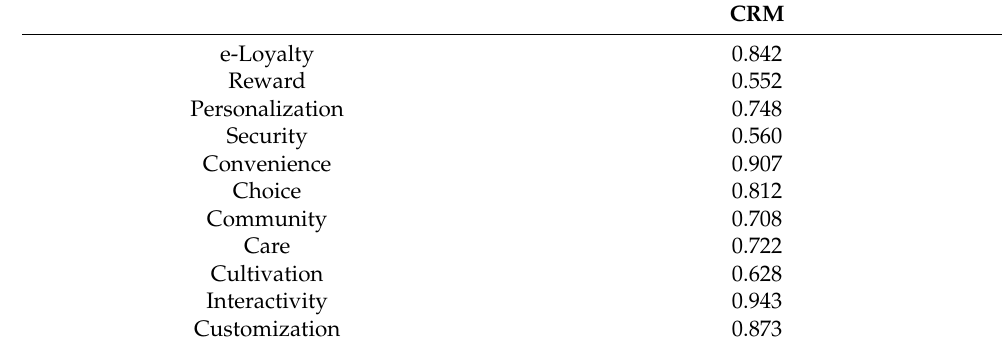
Table 5. Standardized total